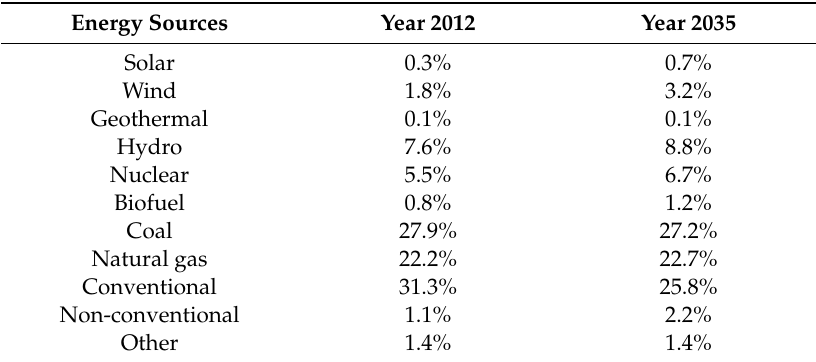
Table 1. Energy sources in the world’s total energy supply